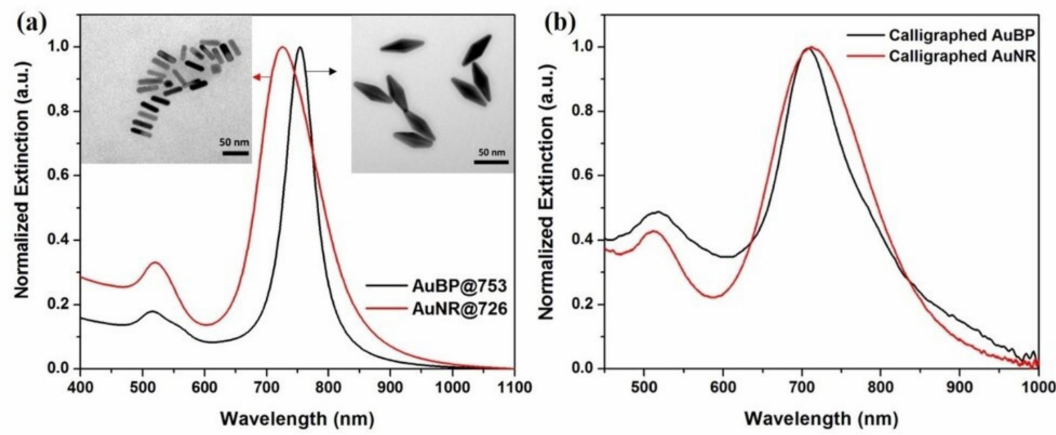
Figure 1. Normalized extinction spectra ( a ) of the colloidal AuBPs (black spectrum) and AuNRs (red spectrum) together with two representative TEM images and ( b ) collected directly from the calligraphed AuBPs (black spectrum) and AuNRs (red spectrum) lines onto the Whatman